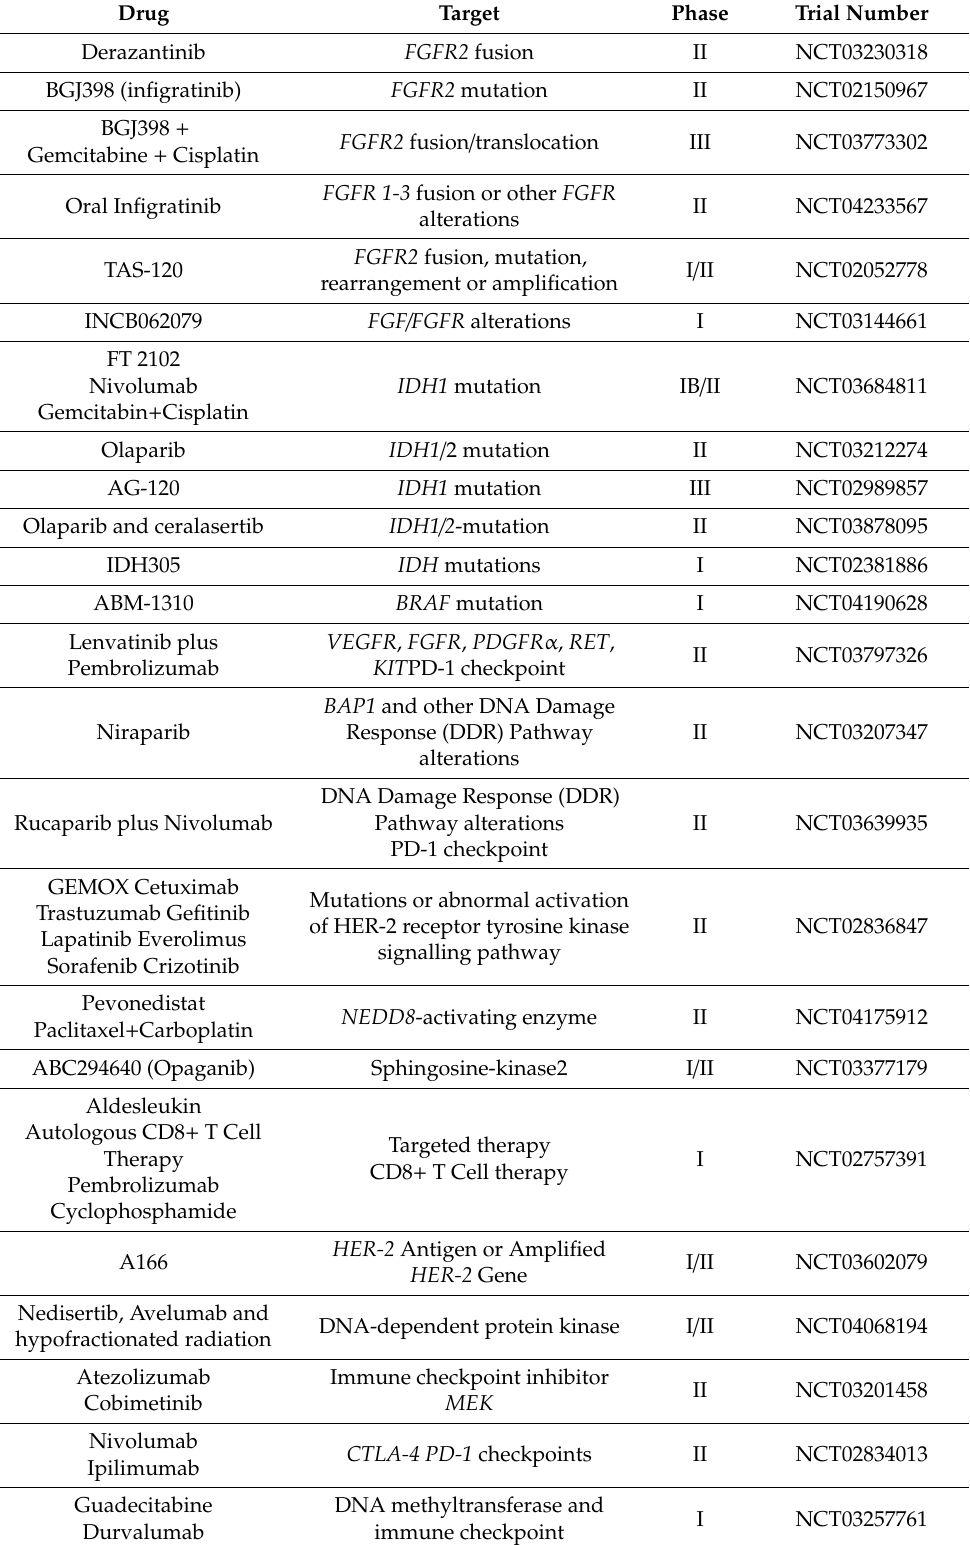
Table A2. Ongoing (active / recruiting) clinical trials using targeted / combination therapies in patients with cholangiocarcinomas